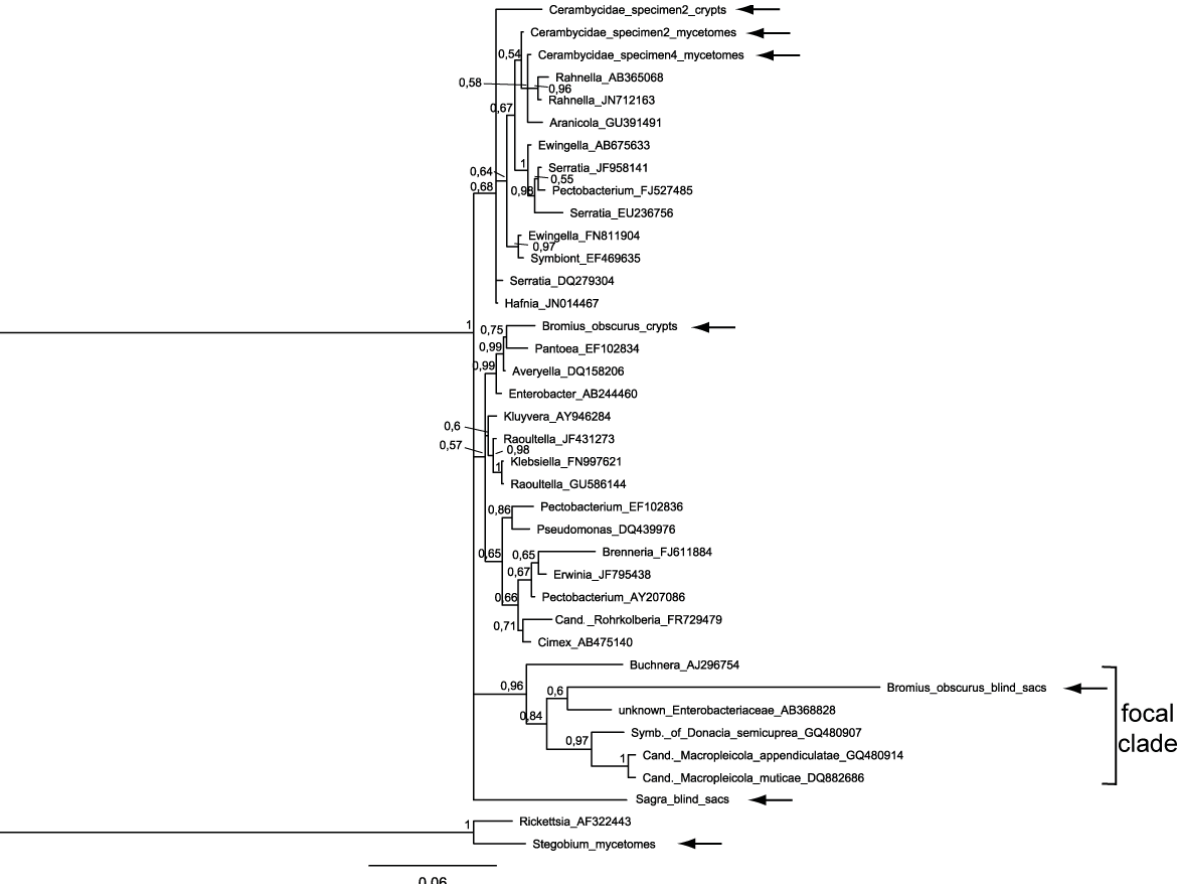
Figure 4. Relationship to closely related taxa of the bacteria analyzed in the present study (horizontal arrows), based on partial 16S rRNA sequences (dataset ‘Enterobacteriaceae’). The tree was constructed using MrBayes. Posterior probabilities are given to the upper left of each node. For further explanations, see Figure 2.